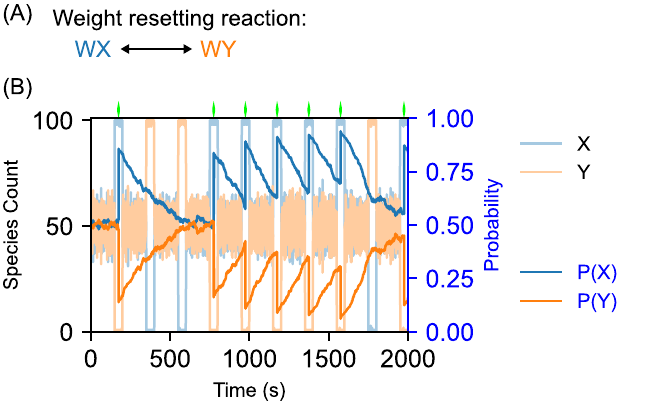
Fig 5. Forgetting weights in operant conditioning systems. (A) Additional reactions to incorporate forgetting into a simple binary probabilistic choice system. The rate constants for the forward and backward reactions in the weight resetting reactions are kWeightReset = 0.003. By enabling the weight species to interconvert at a low rate, they will tend to revert to the evenly-distributed equilibrium when conditioning reactions are not driving them away from this state. Thus, if no relevant feedback is provided over some time period, the system will tend to “forget” the trained weights. (B) Representative time course from an operant conditioning simulation with weight forgetting. This uses a simple binary choice system augmented with the weight resetting reactions outlined in part (a). Starting with 500 copies of each weight species, 10 stimulus/relaxation cycles are performed with 50 time units of Stimulus and 150 seconds of relaxation. The environment responds to state X with 200 Good molecules and does not respond to state Y at all. Rate constant parameters used in this simulation were kBias = 3, kAM = 1, kNoise = 1, kFB = 1, kFBDeg = 1, kWeightReset = .003. Positive feedback on the initial choice of X causes P ð X Þ to increase, but the lack of feedback on subsequent choices of Y causes P ð X Þ to decay back to the equilibrium state; a subsequent run of X choices causes P ð X Þ to increase and remain high while positive feedback is continually received. (For this simulation, the appropriate transfer curve from Fig B from S1 Text for 1000 total weight molecules was used to calculate decision probabilities from the weight species counts. A total count of 1000 weight species was used so that a higher weight-resetting rate could be used, ensuring a more consistent decay